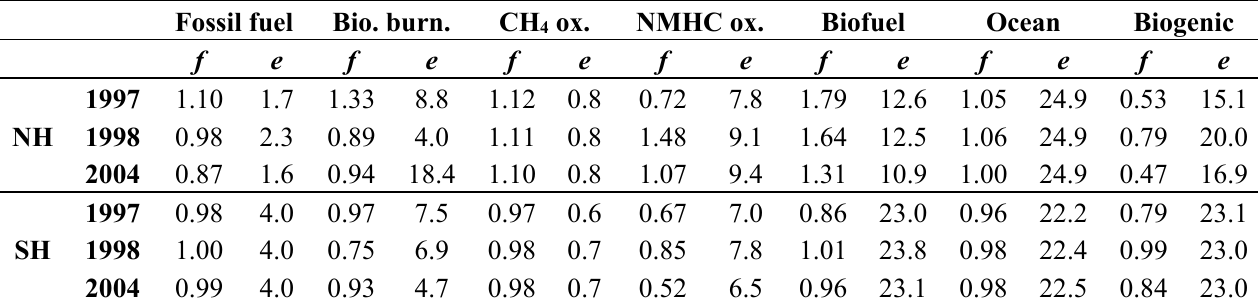
Table 3. Optimization factors ( f ) and a posteriori uncertainty ( e , % ) of each CO source. Fossil fuel Bio.